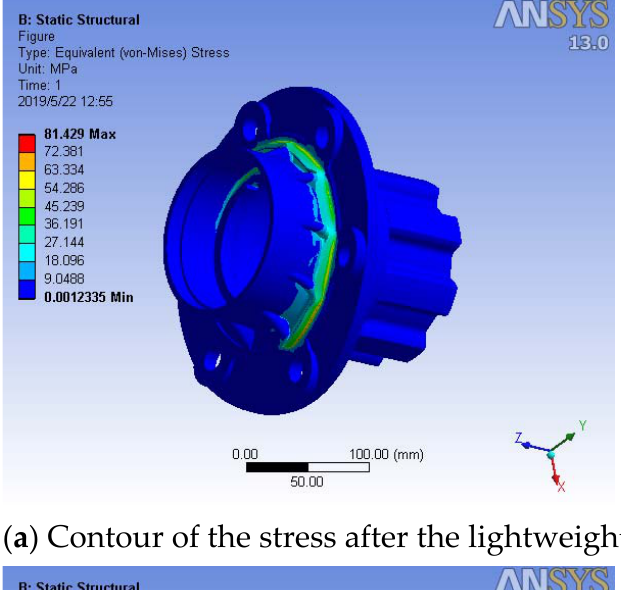
Figure 10. Meshing of the wheel hub after the lightweight design.